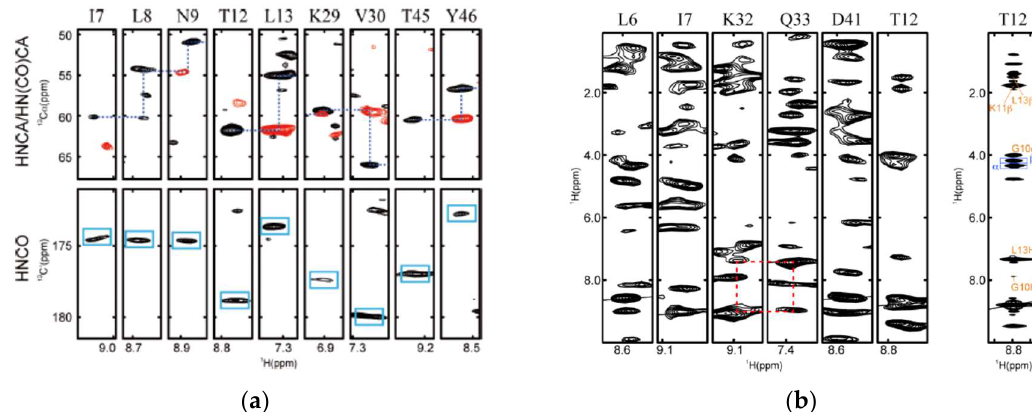
Figure 2. 3D NMR spectra collected in sf9 cells. ( a ) 3D HNCOCA (red), HNCA (black) and HNCO spectra of GB1 in sf9 cells. Blue box indicate the C’ signals. ( b ) Selected strip plot at 1 HN− 1 H dimensions from the 3D a 15 N-separated NOESY spectrum of GB1 expressed in sf9 cells. The Cα connectivity and sequential NOEs are indicated as blue and red lines, respectively. This figure was reprinted with permission from the reference [71]. Copyright (2013) American Chemical Society. For more experimental details, please refer to the original publication.